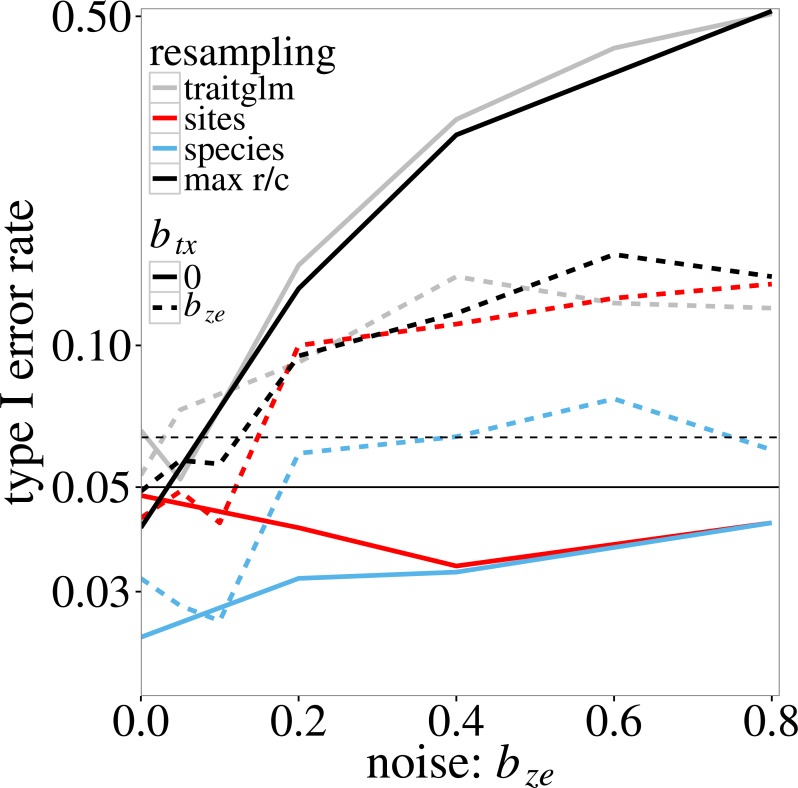
Type I error rate of the four tests of ‘Statistical tests on trait-environment interaction’ on the trait-environment (t–e) interaction in the log-linear simulation model of Eq. (5) in relation to the size of the z–e nuisance interaction (of e with a latent trait z): anova.traitglm (site-based bootstrap with negative-binomial likelihood) and sites (site-based permutation with Poisson likelihood), species (species-based permutation with Poisson likelihood), and max r/c (GLM based pmax test that combines the sites and species tests).The t–x nuisance interaction (of t with a nuisance environmental variable x) is either absent (solid lines) or equal to the size of the z–e nuisance interaction (dashed lines). The vertical scale is logarithmic. The data were generated using a negative-binomial distribution with variance function \documentclass[12pt]{minimal}
\usepackage{amsmath}
\usepackage{wasysym}
\usepackage{amsfonts}
\usepackage{amssymb}
\usepackage{amsbsy}
\usepackage{upgreek}
\usepackage{mathrsfs}
\setlength{\oddsidemargin}{-69pt}
\begin{document}
}{}${\mu }_{ij}+{\mu }_{ij}^{2}$\end{document}μij+μij2. The horizontal line at 0.05 indicates the nominal significance threshold; error rates above the dotted line (at 0.064) are significantly greater than 0.05.